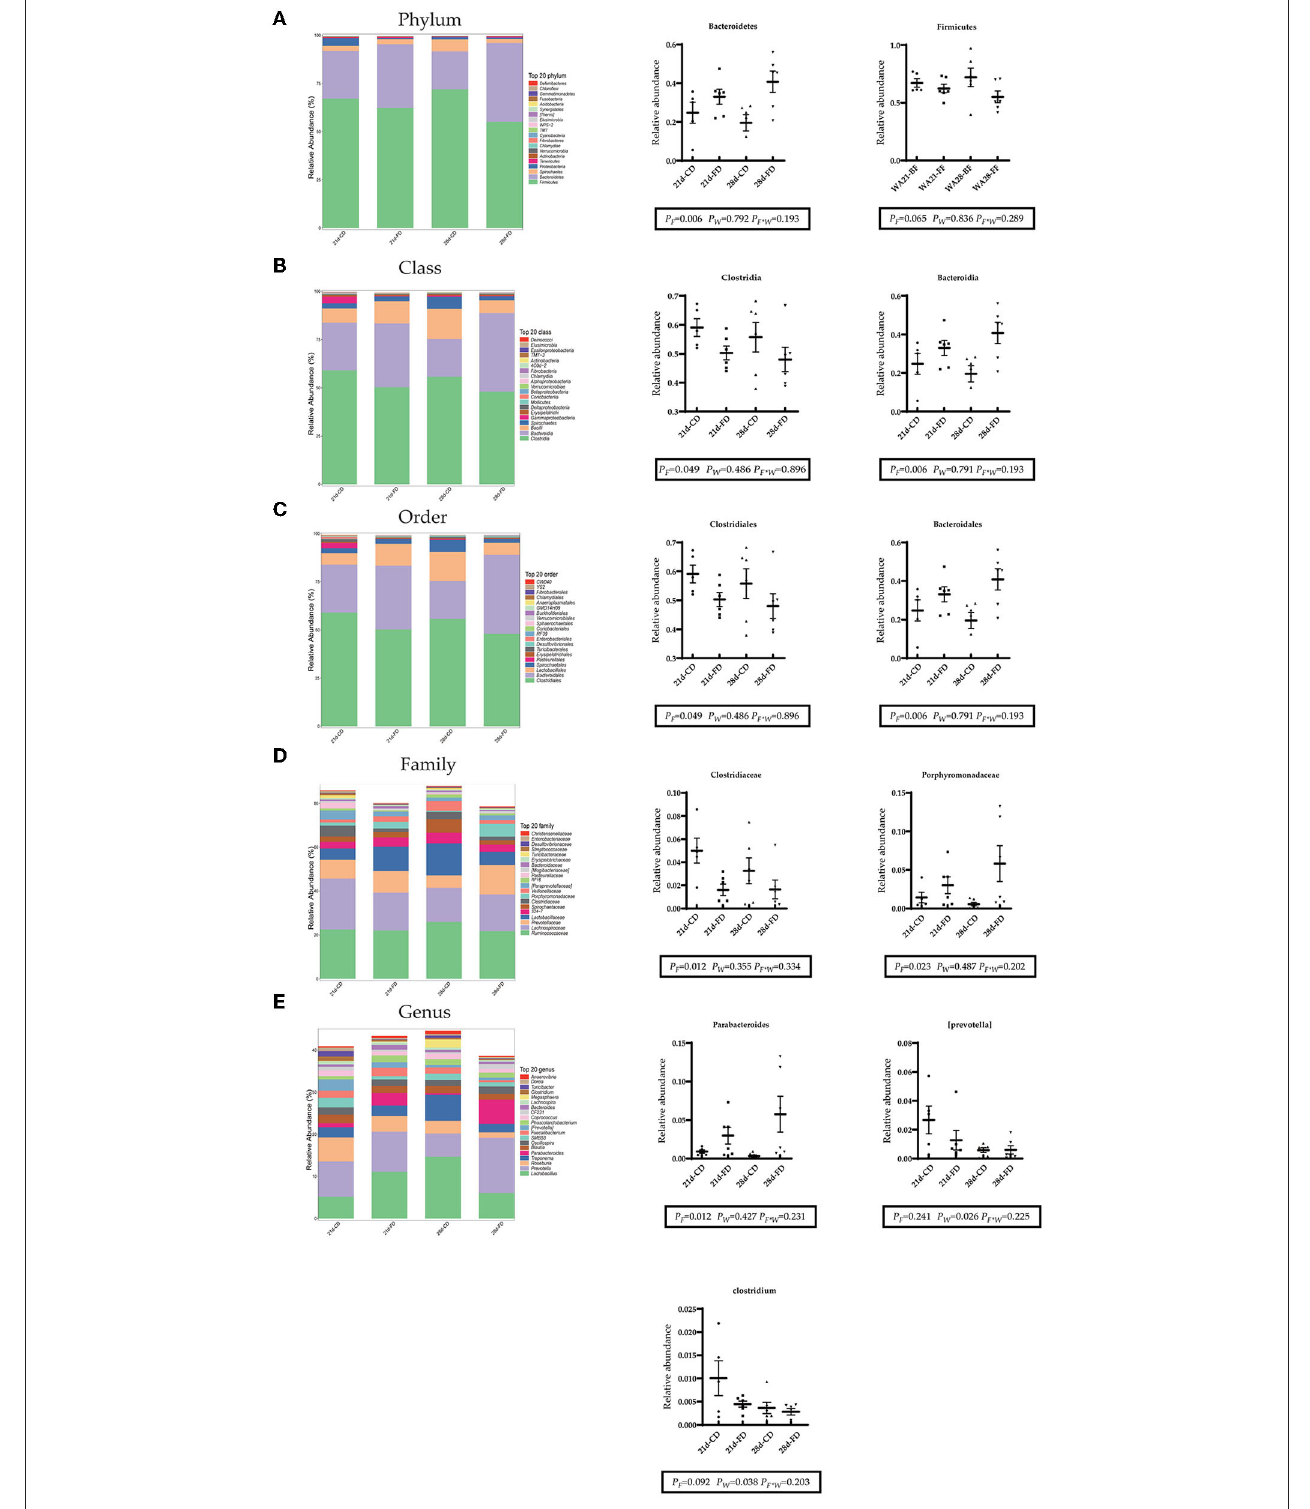
FIGURE 6 | Composition of the top 20 bacteria at the level of phylum, family, and genus. (A–E) The left side of the figure shows the composition of the top 20 bacteria at each level, and the right side shows the top 20 differential bacteria at each level. 21d-CD, 21-day-old weaned piglets fed the control diet. 21d-FD, 21-day-old weaned piglets fed the fermented diet. 28d-CD, 28-day-old weaned piglets fed the control diet. 28d-FD, 28-day-old weaned piglet fed the fermented diet. F, the main effect of fermented diet. W, the main effect of weaning age. F*W, the interaction effect between fermented diet and weaning age. Values are presented as the mean ±